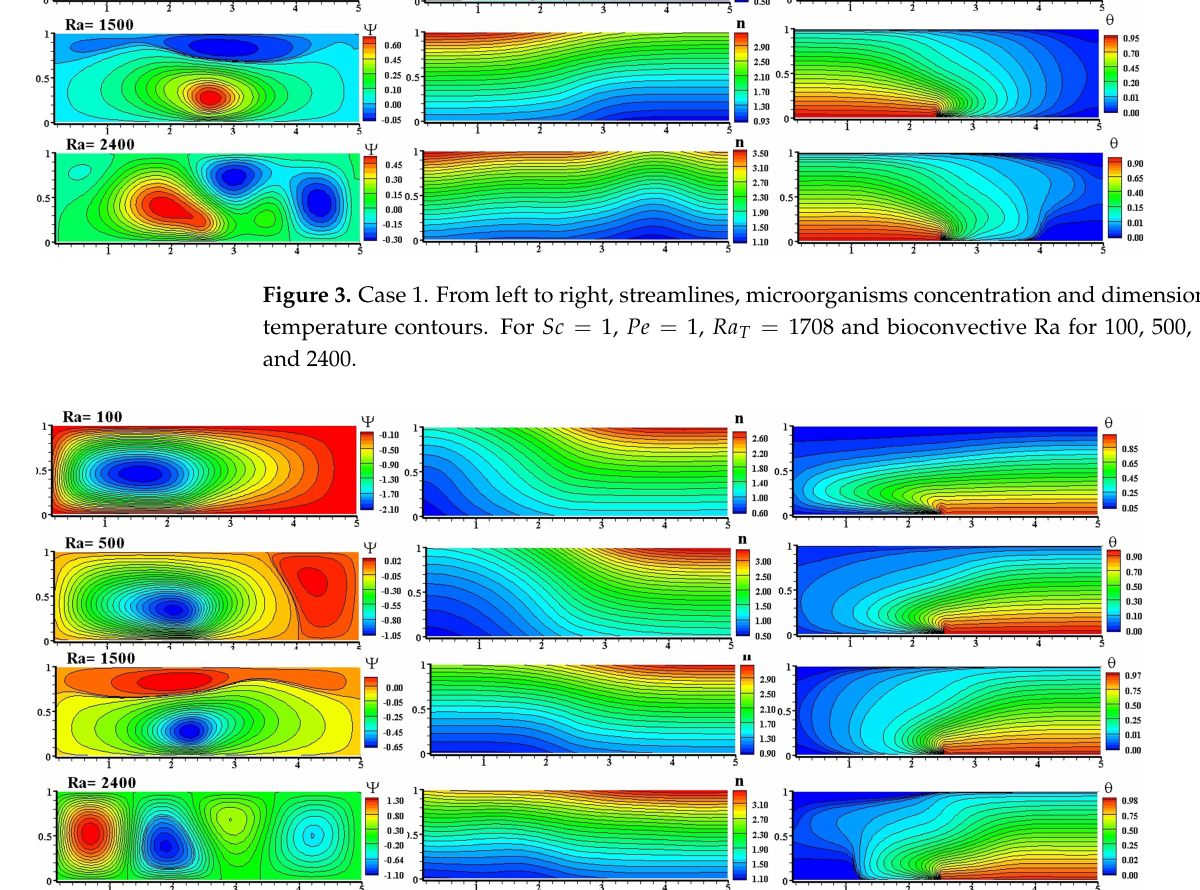
Figure 4. Case 2. Streamline, microorganisms concentration and dimensionless temperature contour at left, center and right, respectively. Sc = 1, Pe = 1, Ra T = 1708 and bioconvective Ra for 100, 500, 1500 and